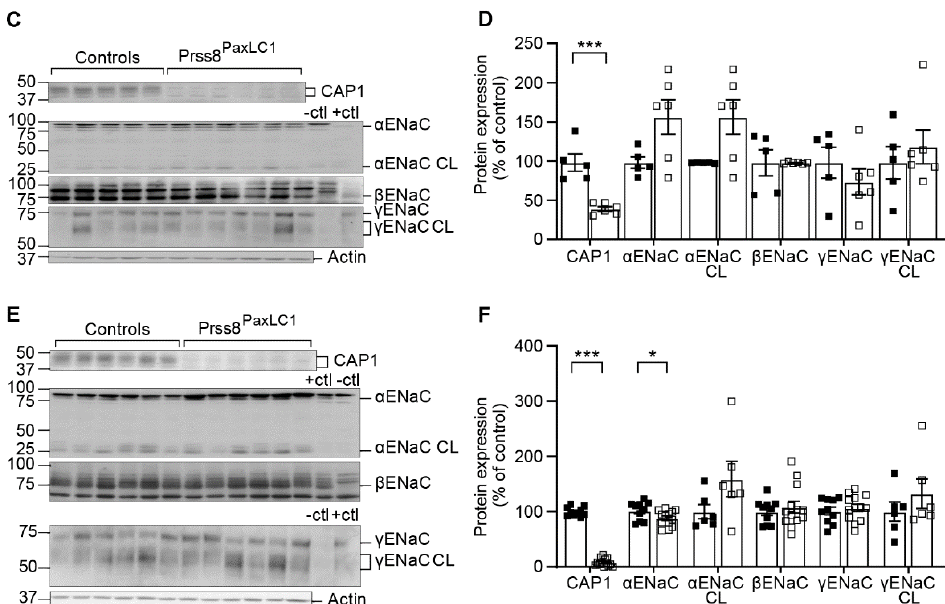
Figure 4. α - and γ ENaC subunits were still cleaved in Prss8 PaxLC1 Ko mice under standard, high and low Na + diet. Representative Western blot analyses of CAP1/Prss8, αENaC, αENaC CL (cleaved), βENaC, γENaC, γENaC CL (cleaved) of kidney lysates from control (black) and knockout mice (white square) under ( A ) standard, ( C ) high and ( E ) low Na + diet.; β -actin was used as loading control. Kidney lysates of control and renal tubular-specific knockouts of α ENaC [9], β ENaC and γENaC [7,8] were used as negative ( -ctl) and positive (+ctl) control. ( B , D , F ) Quantification of data. Values are mean ± SEM (2 series of experiments, control n = 10, knockout n = 13) and datasets were analyzed by an unpaired two-tailed t test. p values < 0.05 were considered statistically significant. * p < 0.05, *** p < 0.001.